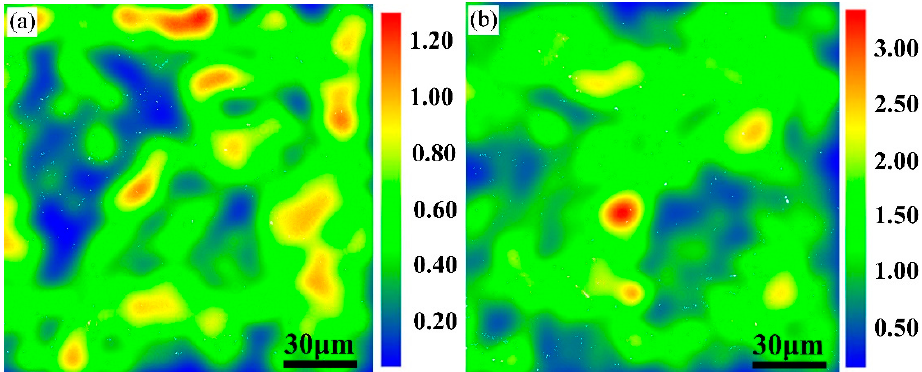
Figure 3. Strain contouring maps of N# steel ruptured sample ( a ) grip; ( b ) gauge.